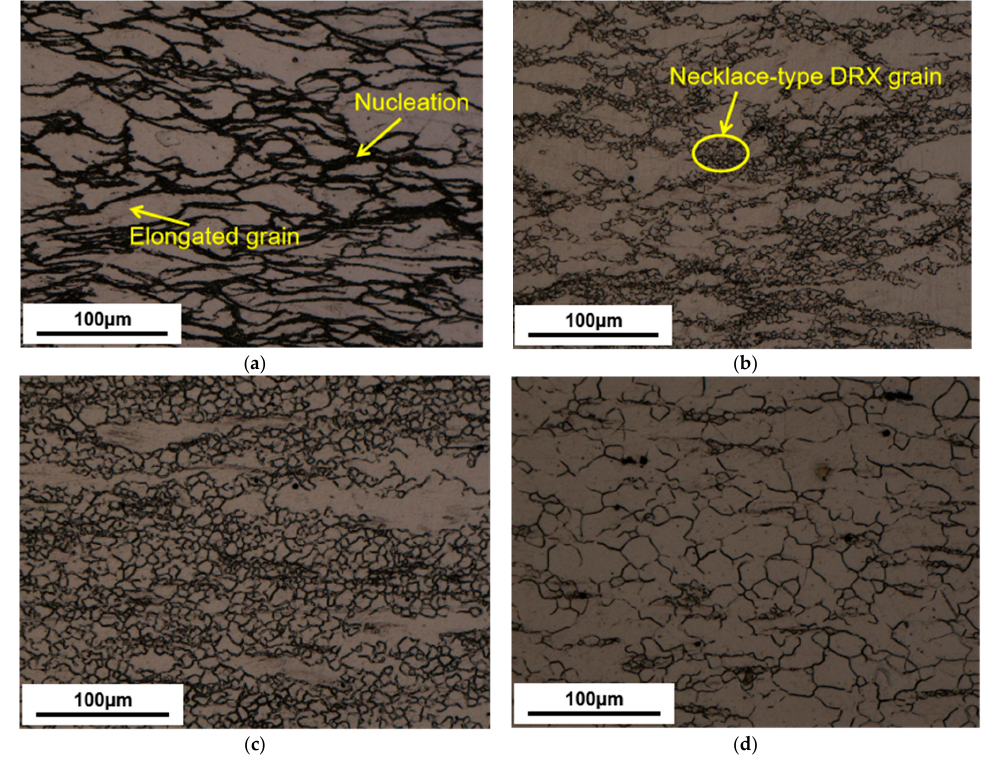
Figure 4. The samples’ microstructure with di ff erent temperatures at 0.01 s − 1 . ( a ) 623 K, ( b ) 673 K, ( c ) 723 K, ( d ) 773 K. ( c ) 723 K, ( d ) 773 K.